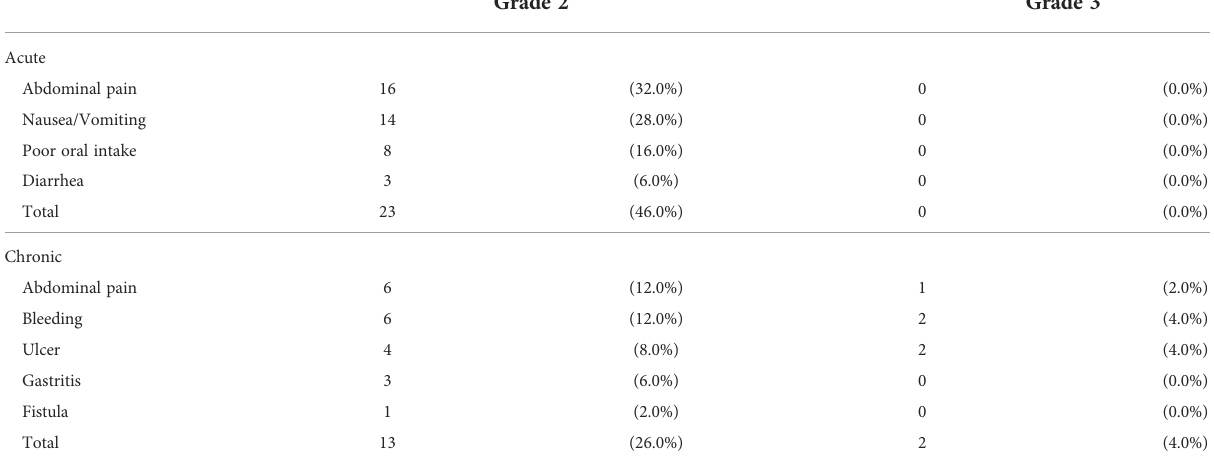
TABLE 4 Acute and late adverse events after